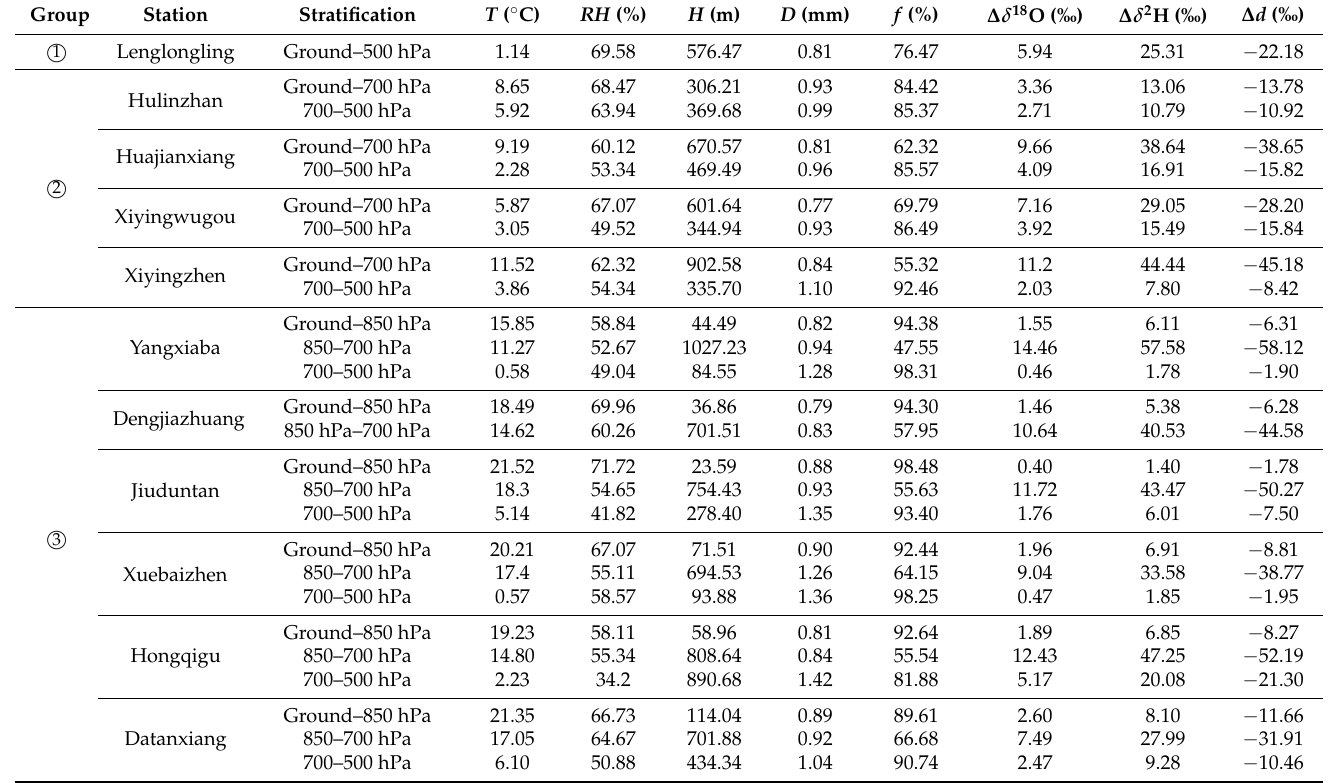
Table 3. Sub-cloud secondary evaporation and environmental factors based on stratification